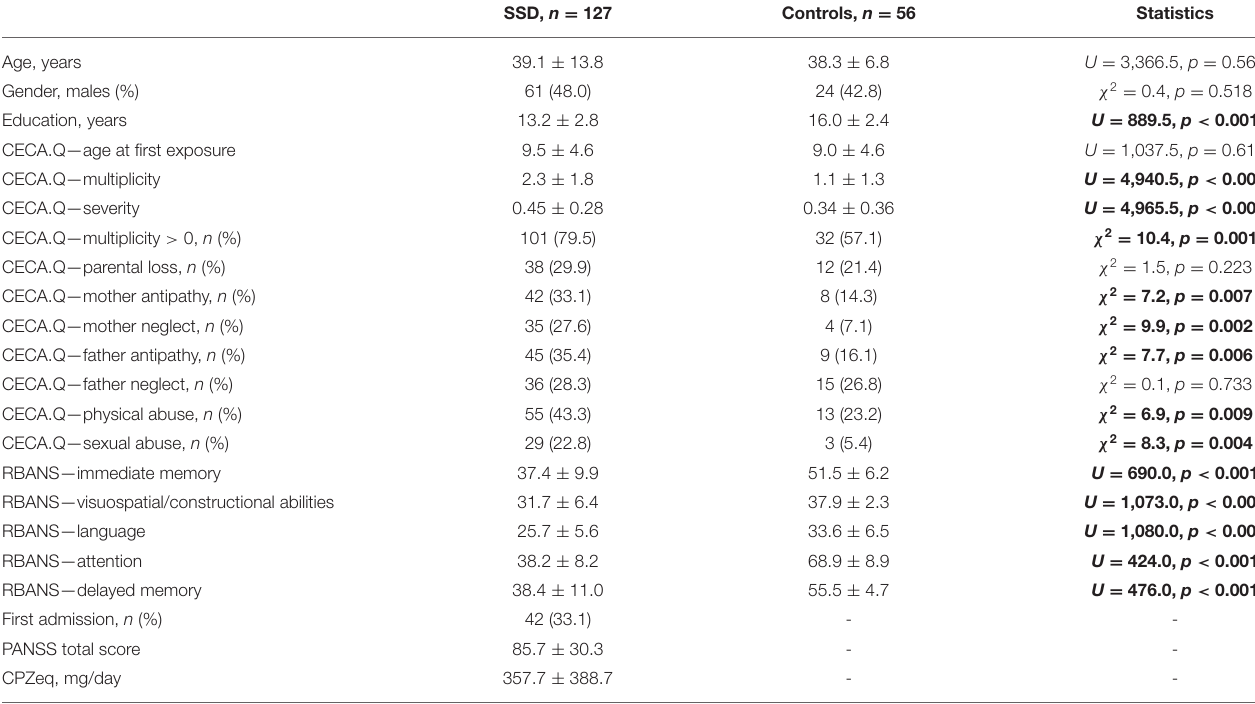
TABLE 1 | General characteristics of the